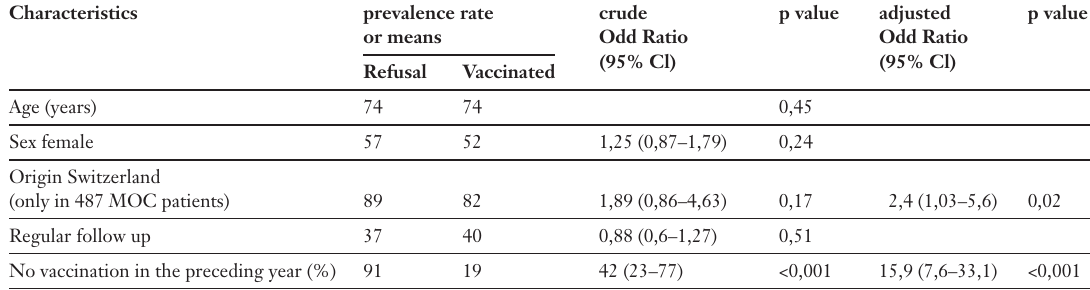
Table 3 Risk factors for